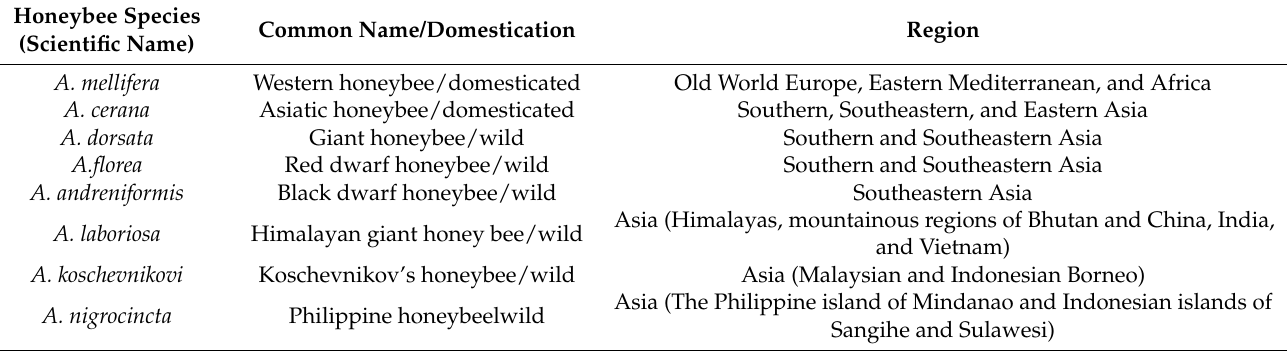
Table 1. The major species of honeybees and their geographical